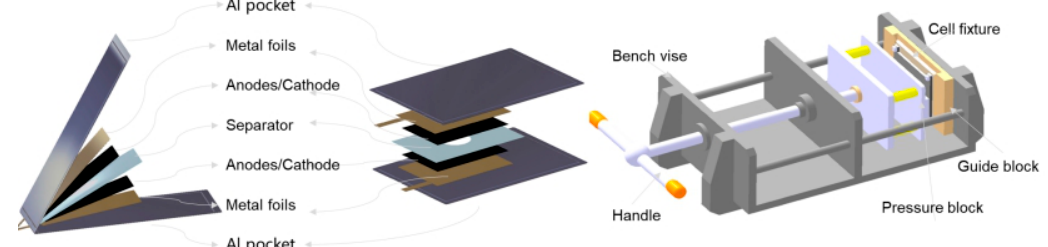
Figure 1. Schematic diagram of assembly and testing of the symmetric cells.